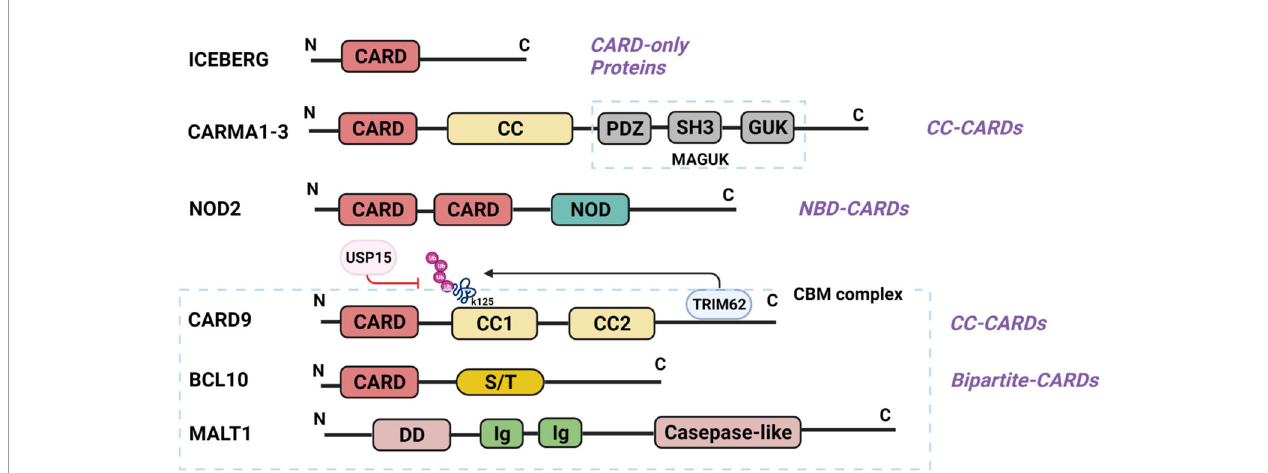
FIGURE 1 | Structure of CARD-containing proteins. There are four sub-groups of CARD-containing proteins, and representative protein structure for each sub- group is shown. ICEBERG belongs to CARD-only proteins. CARMA1-3 belongs to CC-CARDs, which consist of N-terminal CARD, C-terminal CC domains and MAGUK domain (PDZ, SH3 and GUK domain). NOD2, one of the NBD-CARDs, is characterized by two CARD domains at N-terminal and a NOD domain at C- terminal, and can bind with CARD9 via the CARD domain. CARD9 contains a CARD domain at N-terminal and two CC domains at C-terminal, thus belonging to the CC-CARDs. Ubiquitination at K125 is through TRIM62-mediated binding with CARD9 at its C-terminal, while deubiquitination of K125 is a USP15-mediated process. BCL10 comprises of a CARD domain at N-terminal and serine-/threonine (S/T)-rich region at C-terminal, belonging to the bipartite-CARDs. MALT1 consists of an N- terminal death domain (DD), immunoglobulin-like (Ig) domains, and a C-terminal caspase-like catalytic domain. CARD9 binds with BCL10 through CARD-CARD domain, and MALT1 Ig-like domains interact with BCL10 S/T-rich region, thereby forming the CPM complex. (All the fi gures in the review were created with